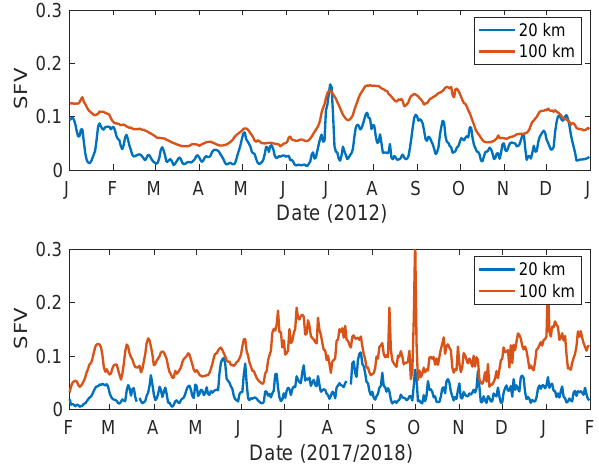
Figure 8. ROMS-evaluated SFV for SPURS-1 ( upper ) and SPURS-2 ( lower ). Red (blue) curves are for 100 km (20 km) footprint size.